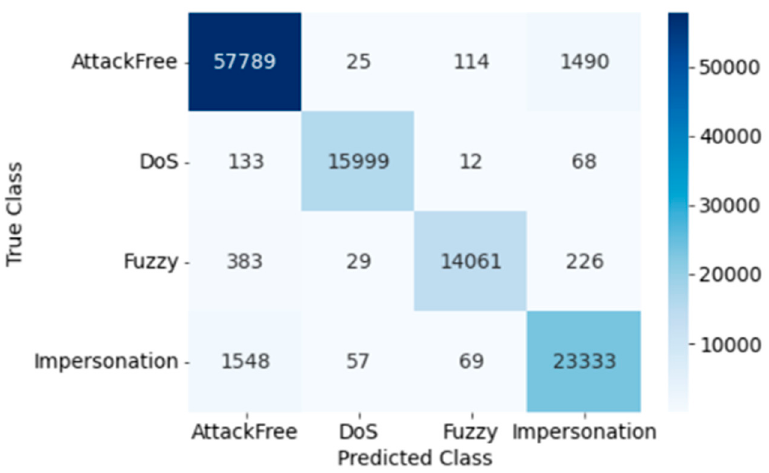
Figure 8. Confusion Matrix of KNN (Dataset 1). Table 5. Detection performance of DoS, fuzzy, impersonation, and attack-free for KNN (Dataset 1).